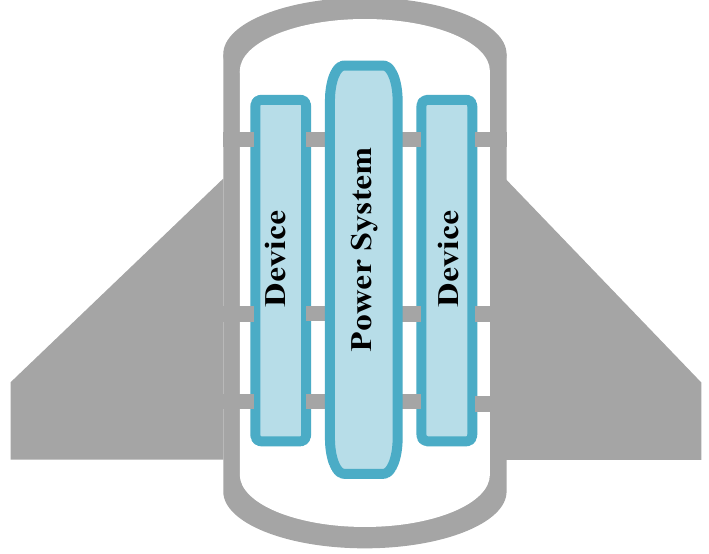
Figure 2. Diagram of the internal structural layout of the AUG.